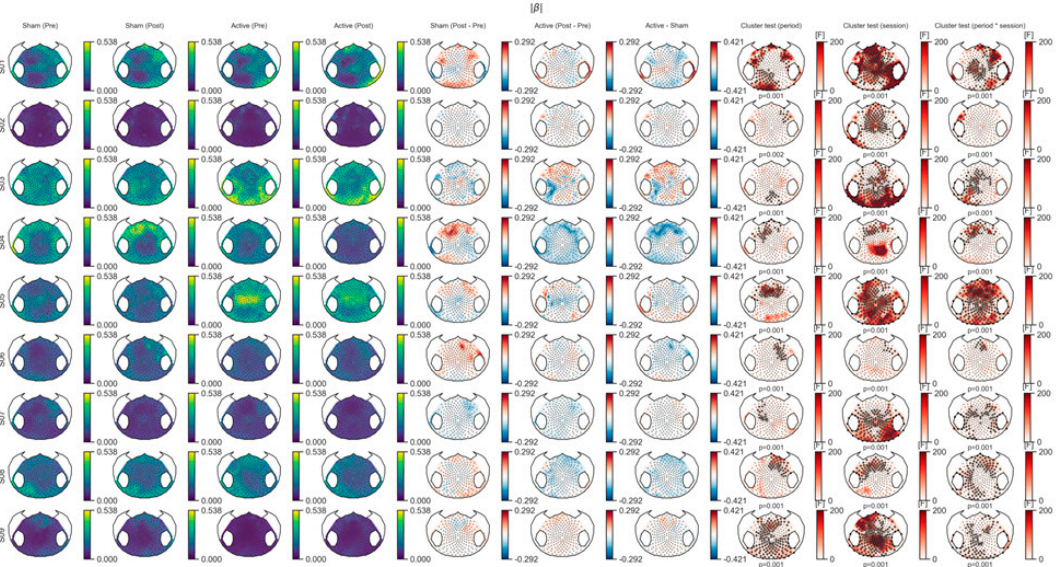
Figure A4. Spectral Power Variability of Beta Band at the Subject Level. The first four columns show the mean power over the epochs for each session and period. Columns 5 and 6 show the power di ff erence in the sham and active sessions, respectively. Column 7 shows the di ff erence between active and sham sessions (i.e., (post-pre) Active –(post-pre) sham ). Columns 8 to 10 show the results of the permutation cluster test on the F values of the ANOVA model to test the significance of the e ff ects of period (post vs. pre), session (sham vs. active), and their interaction, respectively. Table A1. p -Values Obtained for the Weighted Symbolic Mutual Information Connectivity Analysis in the Theta Band.